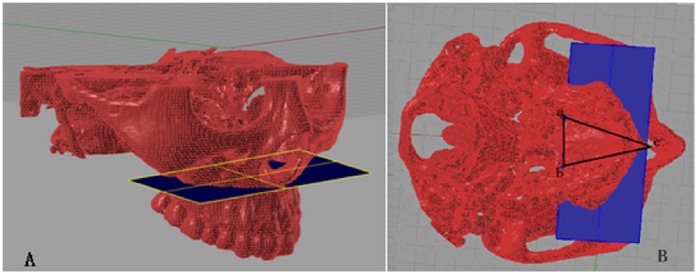
Reference plane for measurement.A. Front view of reference plane; B. Skull base view of reference plane, and three points were identified to ensure the reference plane: a, midpoint of the left greater palatine foramen; b, midpoint of the right greater palatine foramen; c, the forefront of the nasal crest.